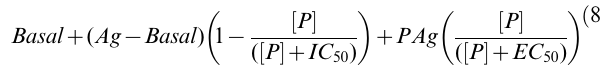
Figure 4 using equation 8: Response ~